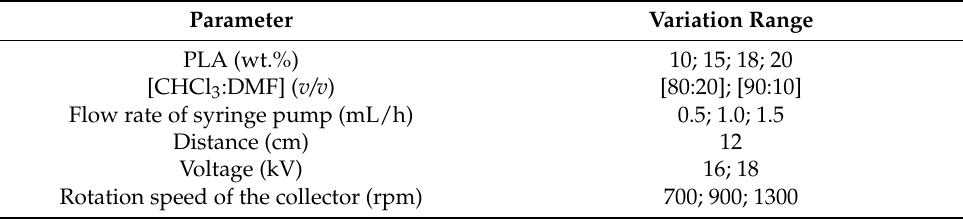
Rotation speed of the collector